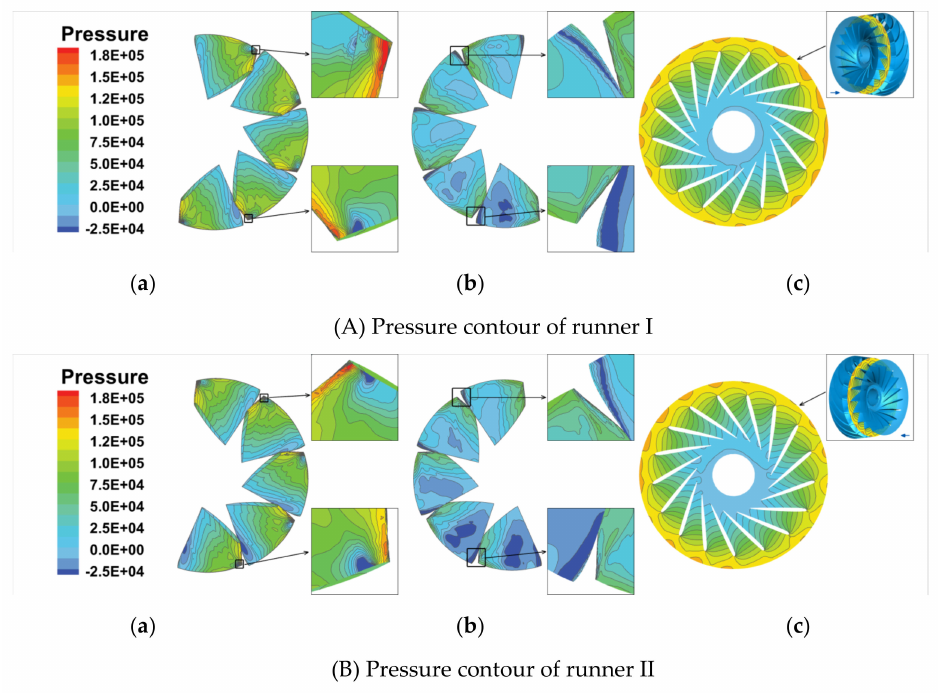
Figure 11. Pressure contour of runner blade and runner flow channel under BEP (a 5 = 110 mm). ( a ) Pressure side of blade; ( b ) suction side of blade; ( c ) runner flow